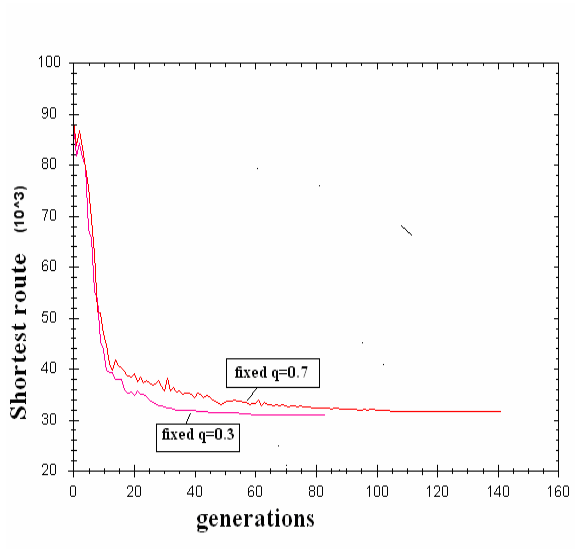
Figure7. The average result 2 of TSP benchmark instances Chn144 by different parameter q